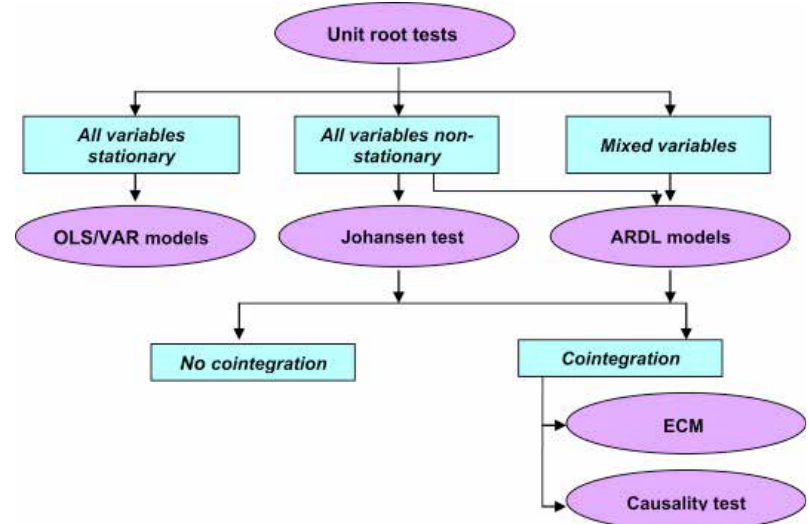
Fig. 2: The methodological flowchart